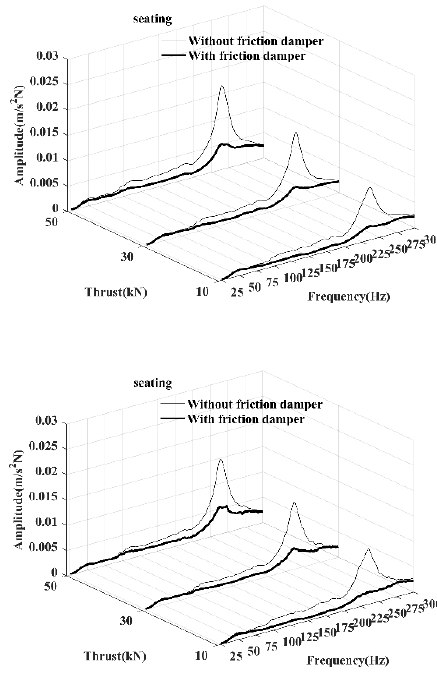
Figure 17. Comparison of experimental AFRF of thrust bearing with and without friction damper.